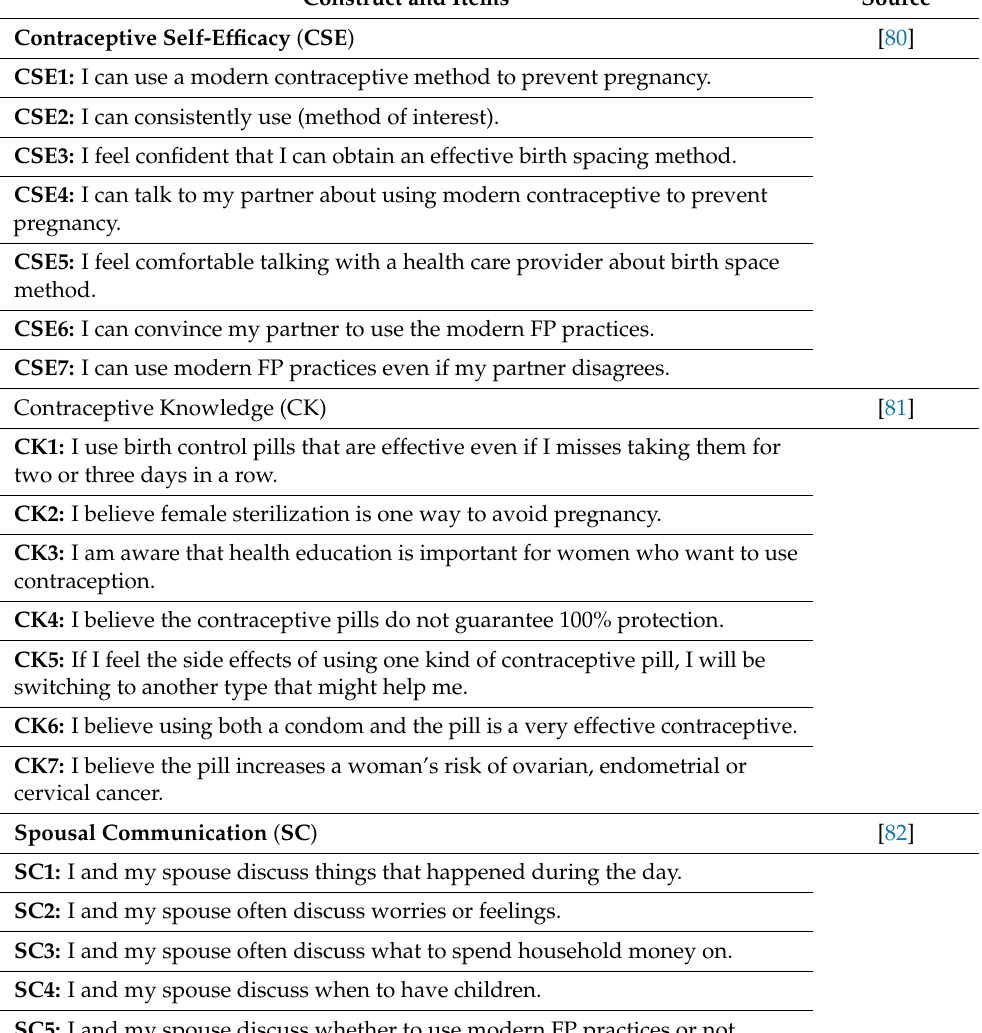
Table A1. Constructs along with their corresponding items. Construct and